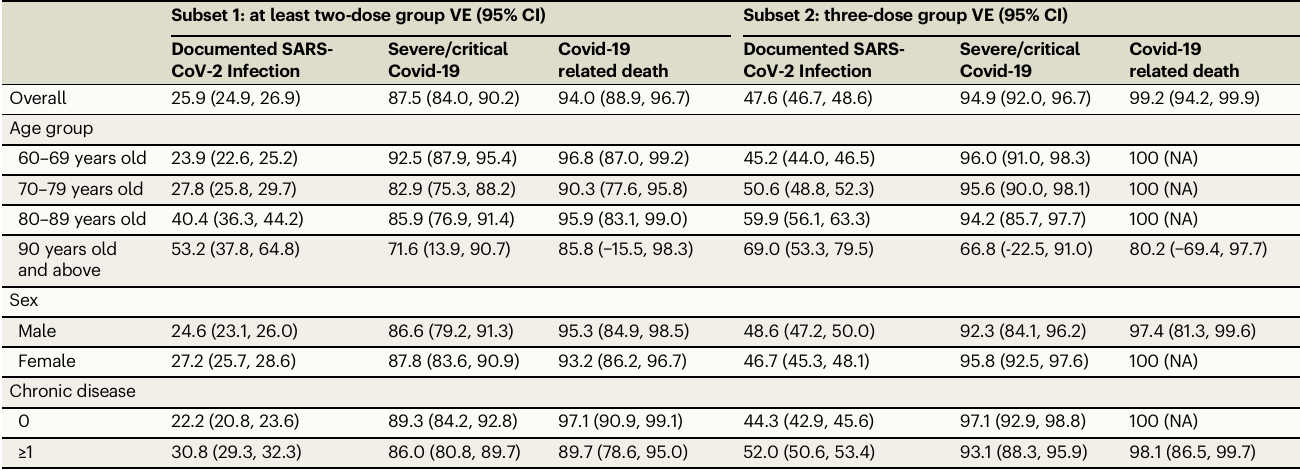
Table 3 | Adjusted vaccine effectiveness against Covid-19 outcomes of at least two-dose, and three-dose of inactivated Covid-19 vaccines versus no vaccination Subset 1: at least two-dose group VE (95% CI) Subset 2: three-dose group VE (95%